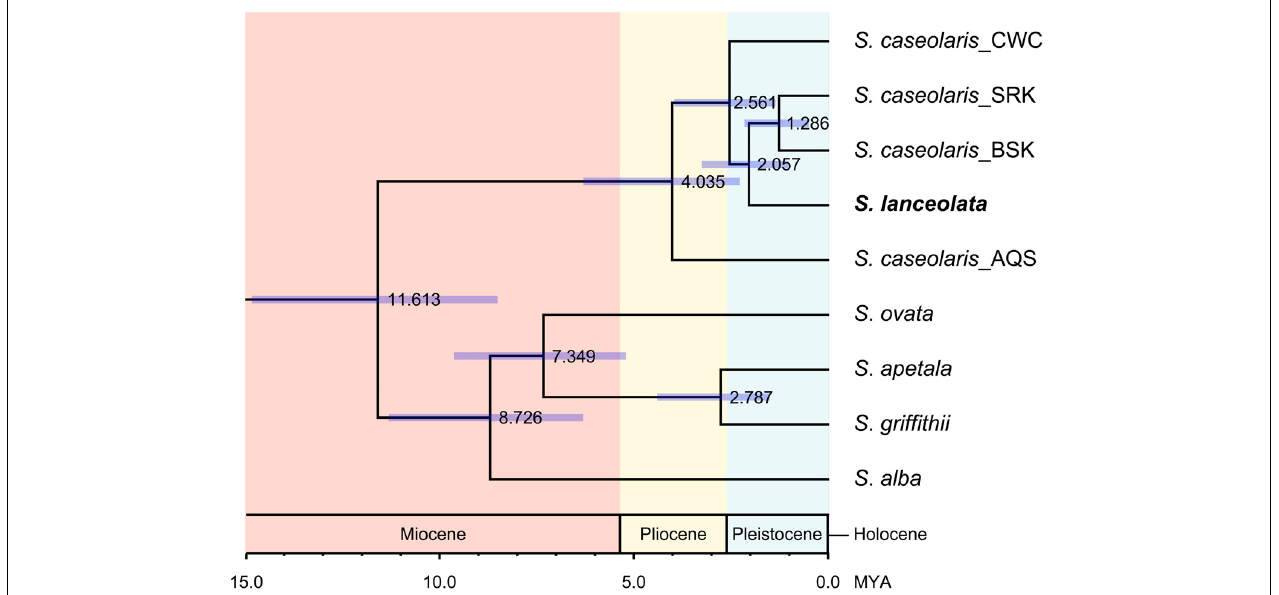
FIGURE 4 | Divergence time of the six Sonneratia species, as well as the different lineages of S. caseolaris . The scale bar is 1.0 million years (MYA). The value and purple bar at each node indicate the estimated divergence time (MYA) with its 95% highest probability density interval